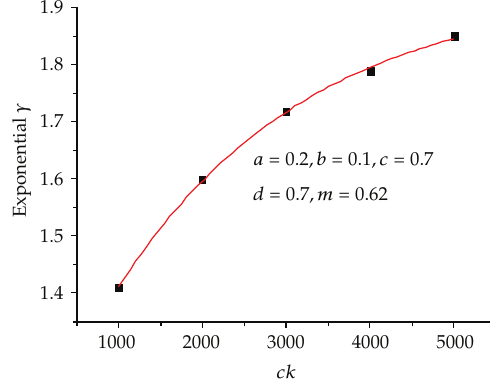
Figure 6: E ff ect of parameter ck on power exponent γ